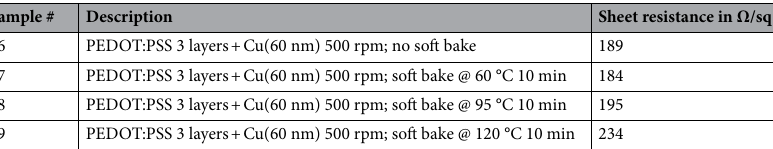
Table 4. Impact of Cu NP deposition parameters and subsequent soft bake on the sheet resistance of the